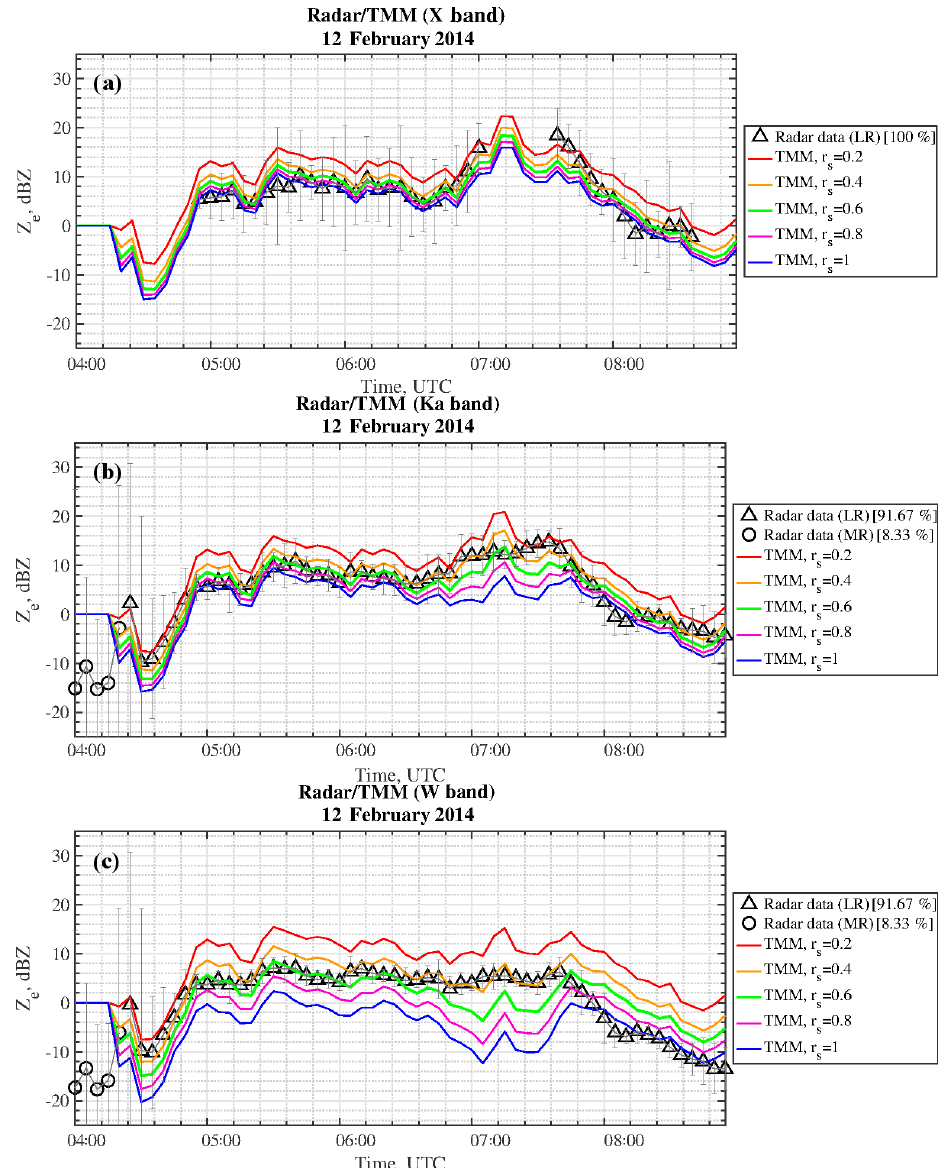
Figure 8. Radar and TMM computations from 12 February 2014 between 04:00 and 08:50UTC for (a) X band, (b) Ka band and (c) W band. Radar reflectivities (LR and MR snowfall in black triangles and circles, respectively) from XSACR, KAZR and MWACR are corrected for sky-noise, calibration offsets and attenuations (as better explained in Sect. 2.4). The error bars are used to represent the variation (min–max difference) of radar data within a 5min window with respect to their averaged value (black triangles and circles). TMM-based computations (red, orange, green, magenta and blue lines for r s = 0 . 2, r s = 0 . 4, r s = 0 . 6, r s = 0 . 8 and r s = 1, respectively) are derived from PIP